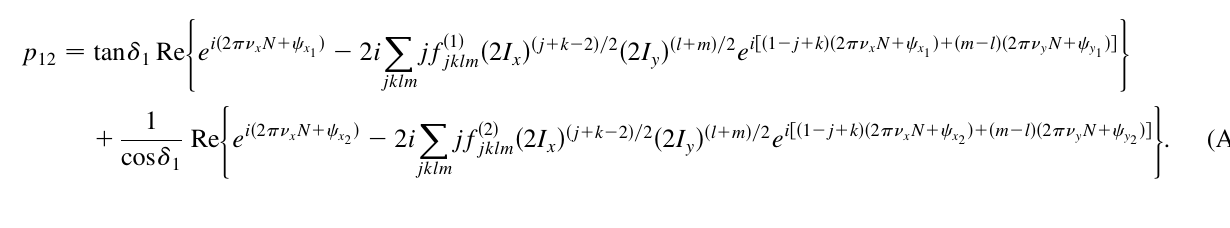
j with an ac dipole. The 3000